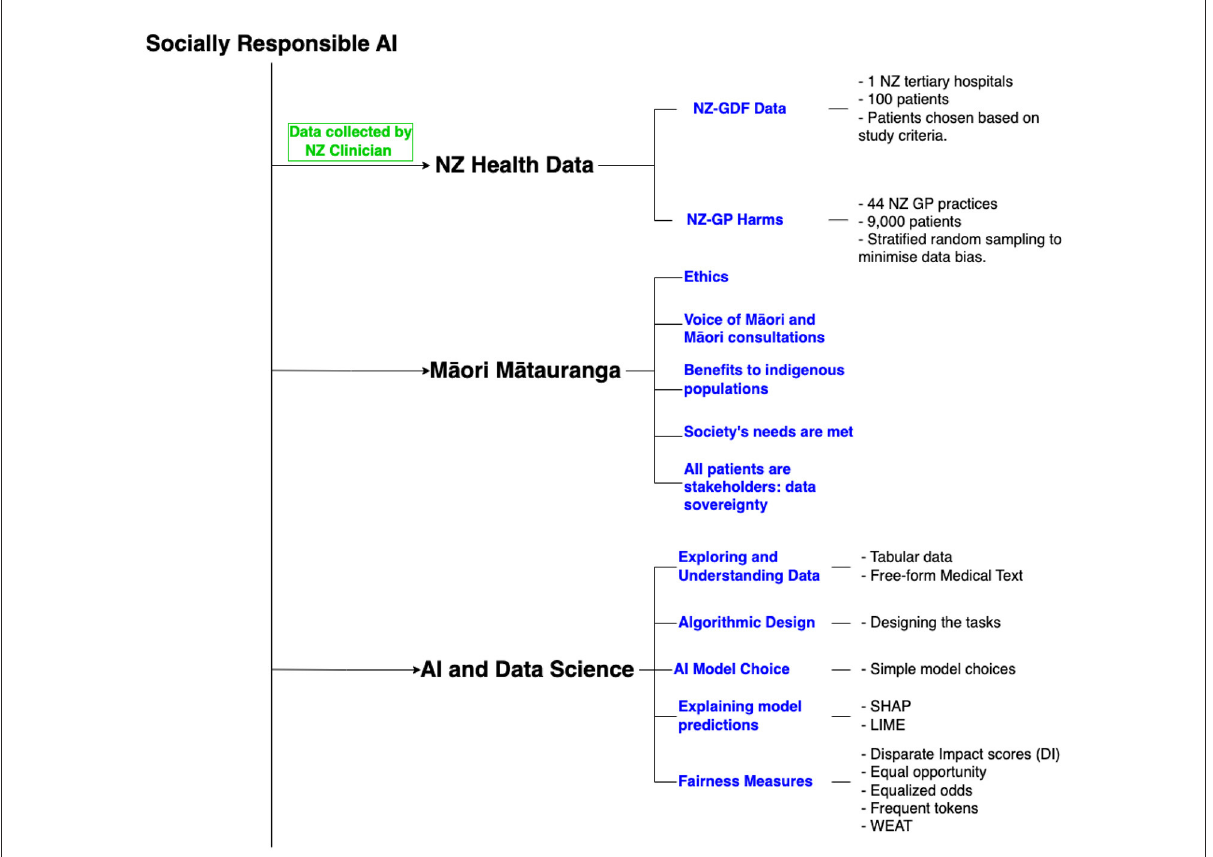
FIGURE2 Overview of research